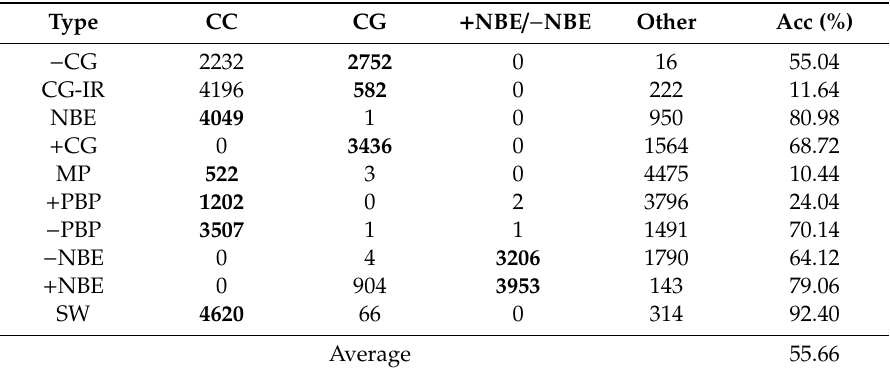
Table 4. Results of statistical